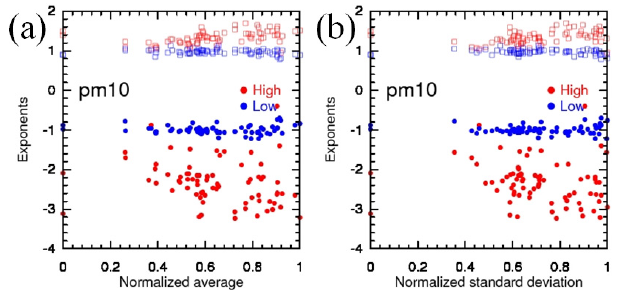
Fig. 13. The relationships between exponents and normalized av- erages (panel a ) and between exponents and normalized standard deviations (panel b ) for PM 10 , respectively. Exponents from high- and low-frequency bands (HFB (red dots) and LFB (blue dots)) of CWT spectra and those from small and large time-lag bands (STLB (red squares) and LTLB (blue squares)) of DFA are